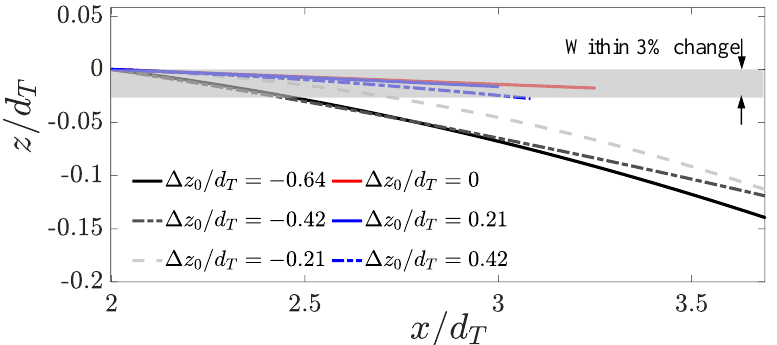
Figure 4. Location of the wake core (velocity minimum around the hub) for the backward- and forward-facing step cases and flat